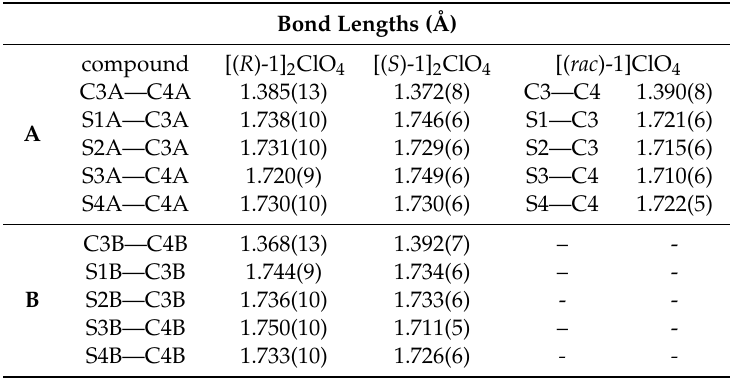
Table 3. Selected C = C and C–S bond lengths for [( rac )- 1 ]ClO 4 , [( R )- 1 ] 2 ClO 4 and [( S )- 1 ] 2 ClO 4